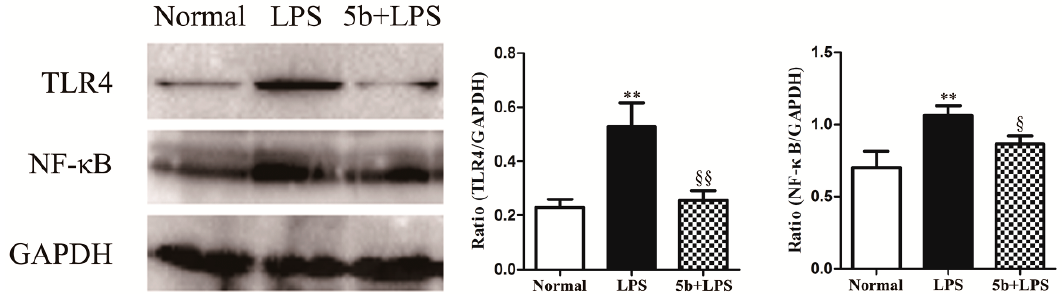
Figure 7. Effect of 5b on expression of NF- κ B p65 and TLR4 in HK-2 cells. Expression of NF- κ B p65 and TLR4 proteins were assessed by Western blot analysis. Data were expressed as means ± SD for three independent experiments. ** p < 0.01 vs. normal group; § p < 0.05 and §§ p < 0.01 vs. LPS group.